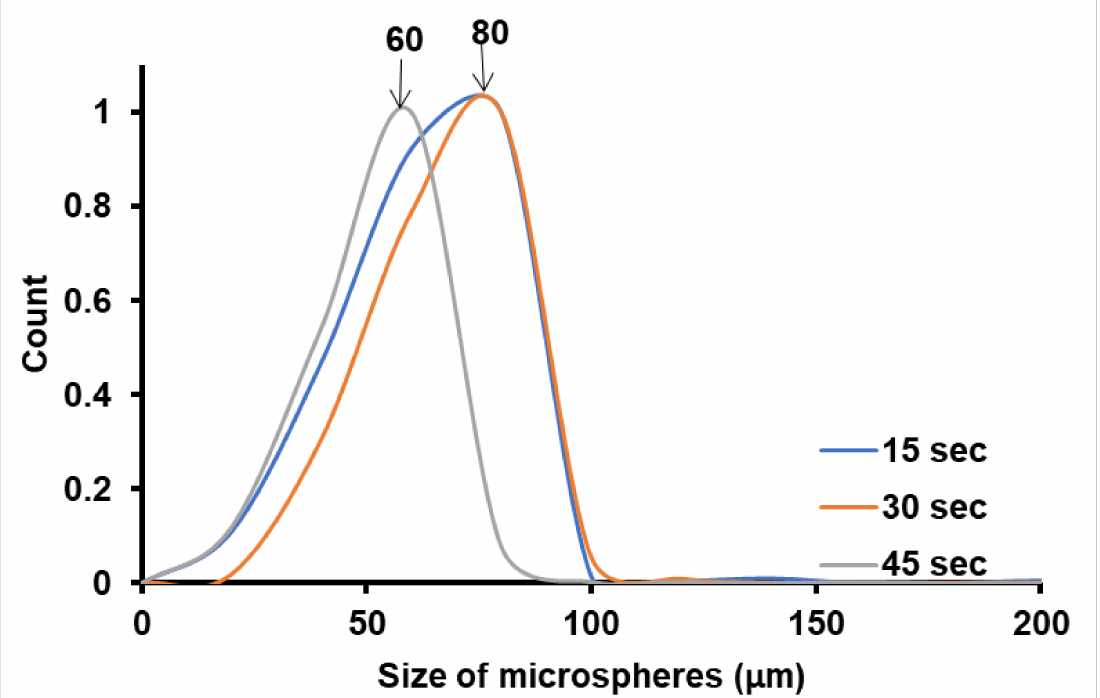
Figure 3. The PBM microsphere size distribution obtained by Pickering emulsion polymerization of BMand stabilized by NP-Gly at different emulsion ultrasonication